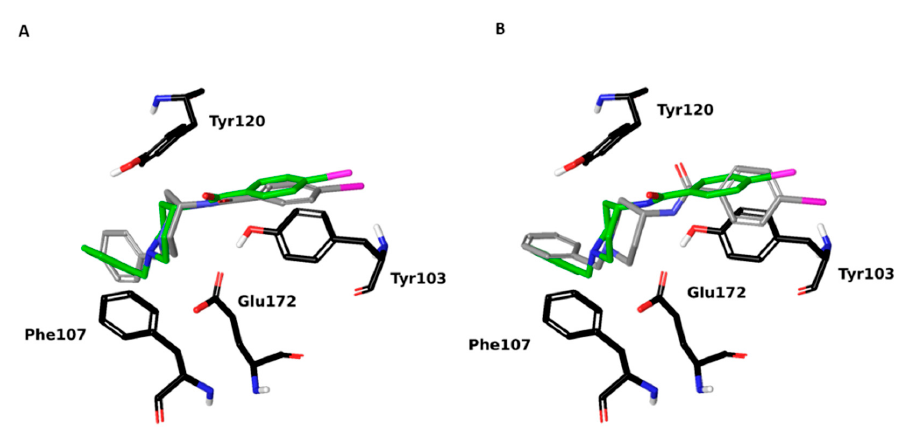
Figure 2. Difference of 4-IBP poses in ligand docking ( A ) and induced fit docking ( B ) from the crystal pose (shown in green color).